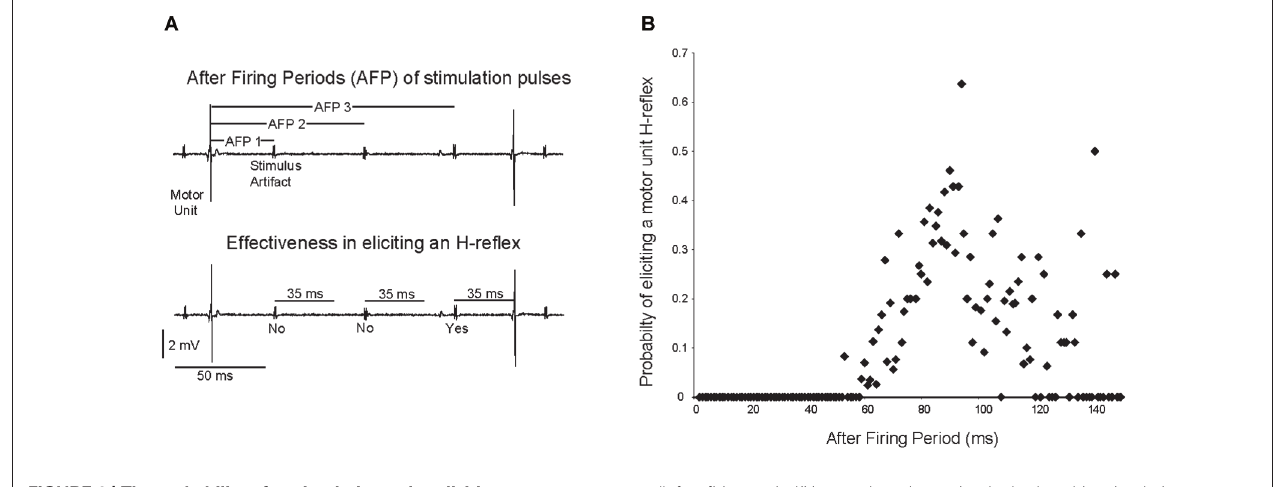
FIGURE 6 | The probability of a stimulation pulse eliciting an H-reflex depends on the time since the motor unit last fired. (A) As shown for a single motor unit, the time since the previous motor unit discharge was measured for each stimulation pulse, and termed the